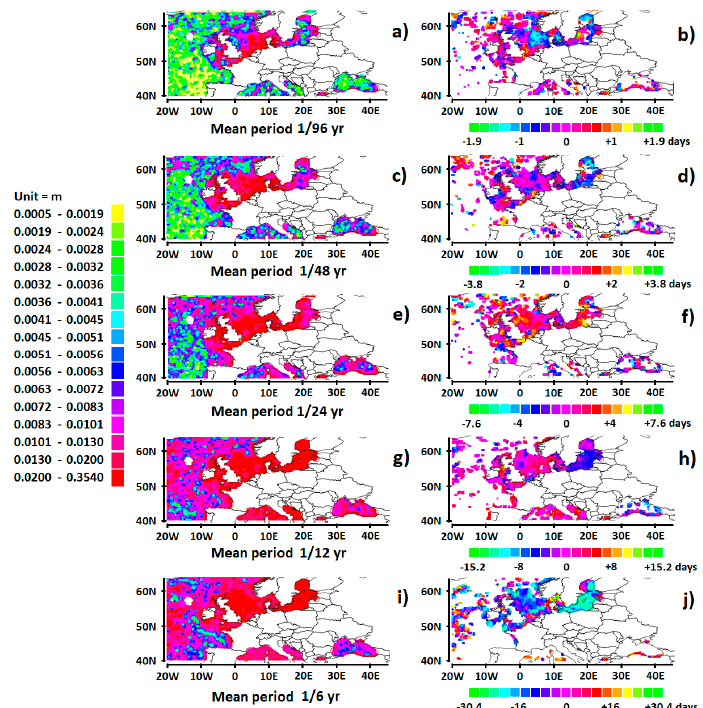
Figure 10. Same as Figure 8 for the amplitude ( a , c , e , g , i ) and the phase ( b , d , f , h , j ) of SSH. SSH anomalies are negative when the time lag is zero. Same data sources as in previous figures.